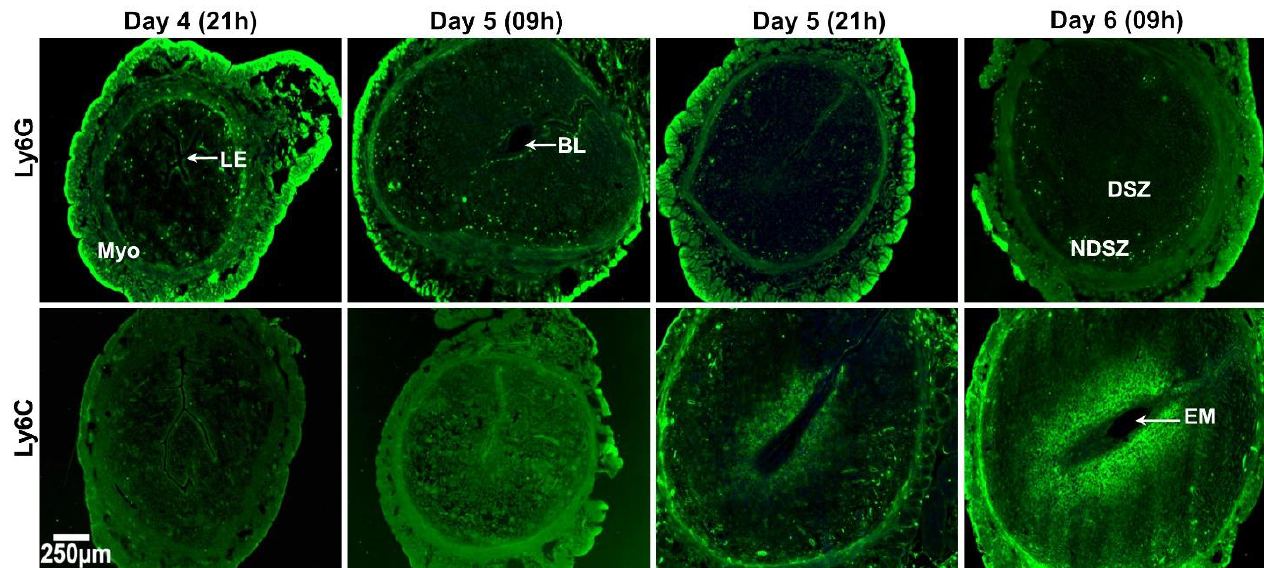
Figure 2. Event-specific change in the distribution pattern of uterine neutrophils and monocytes in the receptive uterus of day 4 (09h) and EBISs of days 5 (09h and 21h) and 6 (09h) of pregnancy. Cross sections obtained from two pieces of uterine tissues/mouse/timepoint of pregnancy were fixed, immunostained with anti-Ly6G and anti-Ly6C antibodies (green), counterstained with DAPI (blue) and photographed. At least three pregnant mice were used at each timepoint of pregnancy. BL, blastocyst; DSZ, decidualized stromal zone; EM, embryo; LE, luminal epithelium; Myo, myometrium; NDSZ, non-decidual stromal zone.